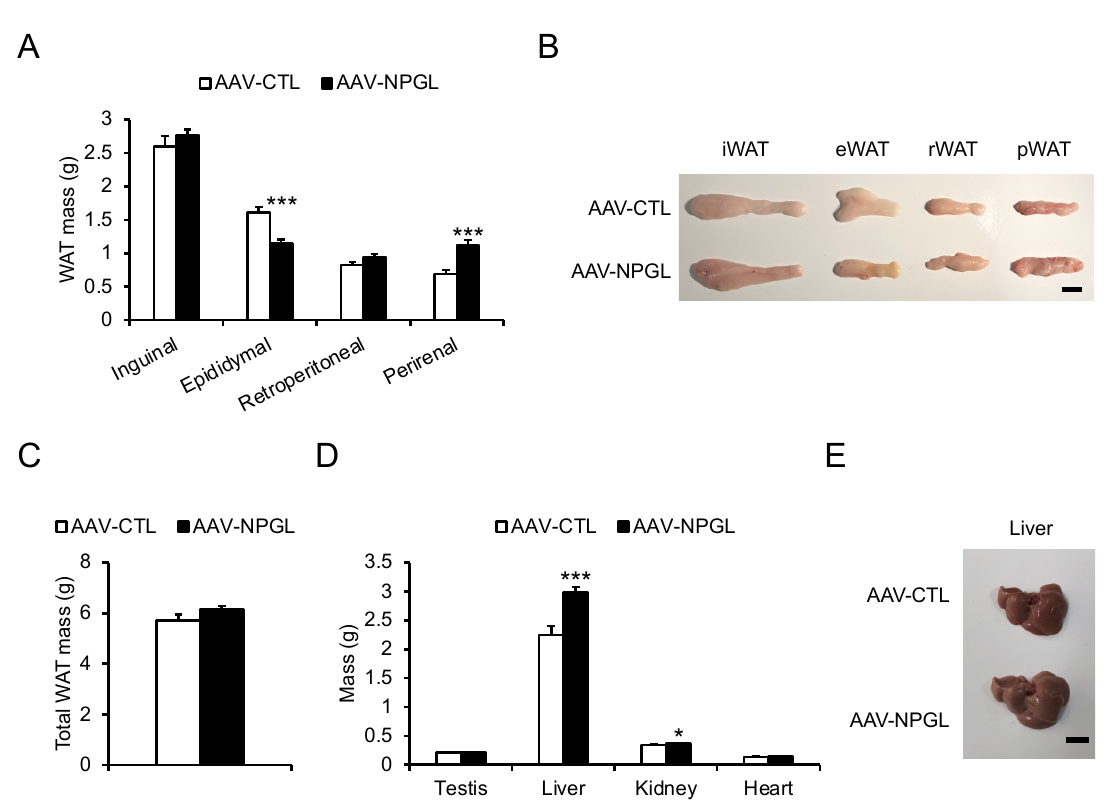
Figure 4. Effects of Npgl overexpression on tissue and organ mass in mice fed a high-fat diet with 60% calories from fat (HFD 60). These mice were injected with an adeno-associated virus (AAV) vector, either a control (AAV-CTL) or a vector carrying the NPGL precursor gene (AAV-NPGL). ( A ) Masses of the inguinal (i), epididymal (e), retroperitoneal (r), and perirenal (p) white adipose tissue (WAT). ( B ) Representative photographs of WAT from each region in HFD 60-fed mice at 18 weeks after injection of AAV-CTL or AAV-NPGL. ( C ) The total WAT mass. ( D ) Masses of the testes, liver, kidney, and heart. ( E ) Representative photograph of the liver in HFD 60-fed mice at 18 weeks after injection of AAV-CTL or AAV-NPGL. Scale bars = 1 cm. All statistical analyses were performed using Student’s t -test. Each value represents the mean ± standard error of the mean (AAV-CTL: n = 8, AAV-NPGL: n = 8; * p < 0.05, *** p < 0.005). With regard to blood biomarkers, Npgl overexpression increased blood insulin levels but did not affect blood levels of glucose, leptin, triglycerides, or free fatty acids (Figure 5).